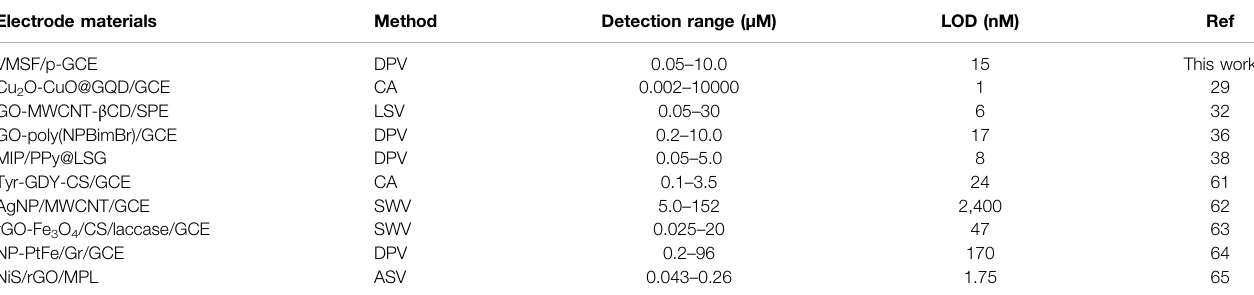
TABLE 1 | Comparison between electrochemical detection of BPA using a different electrode. Electrode